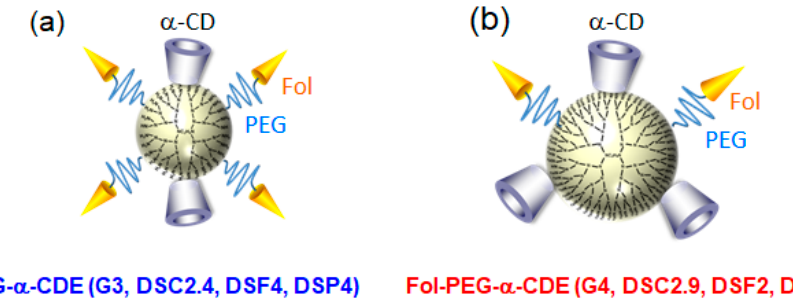
Figure 10. Proposed chemical structures of ( a ) Fol-PEG- α -CDE (G3, DSC2.4, DSF4, DEP4) and ( b ) Fol-PEG- α -CDE (G4, DSC2.9, DSF2, DEP2) as siRNA carriers.